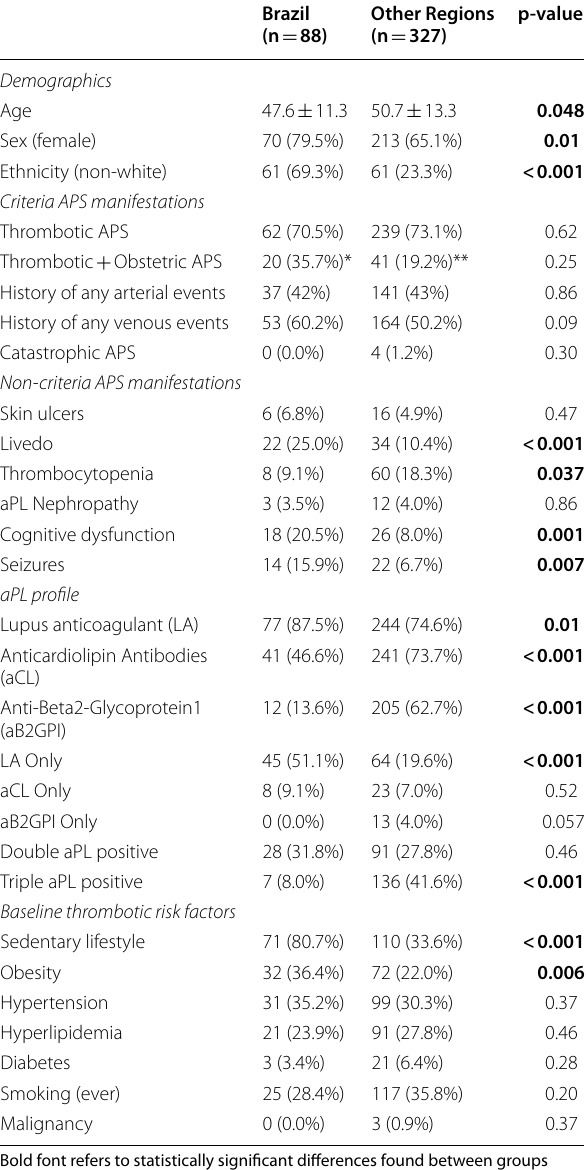
Table 1 Demographics, clinical and laboratory characteristics